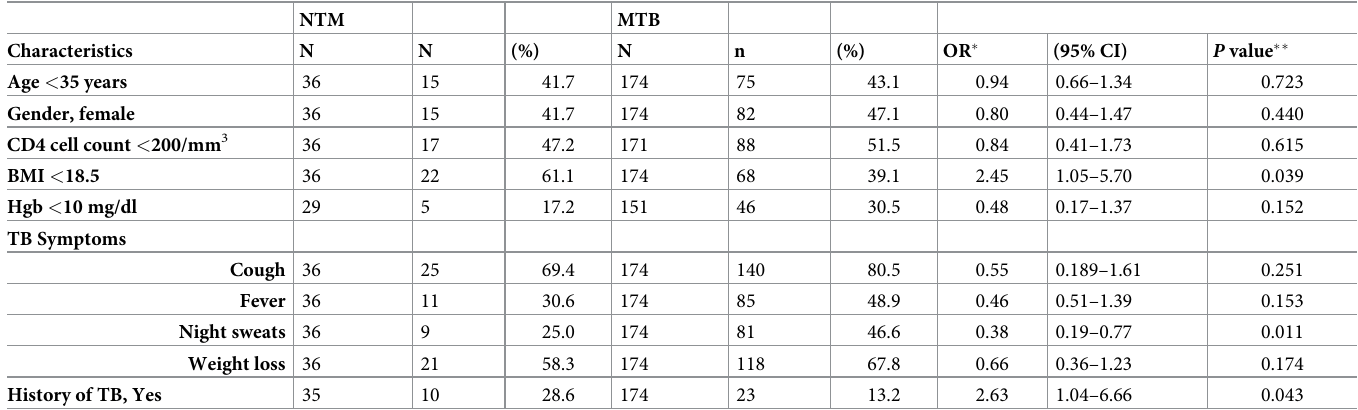
Table 1. Characteristics of patients with NTM or MTB positive culture treated with an anti-TB treatment. NTM MTB